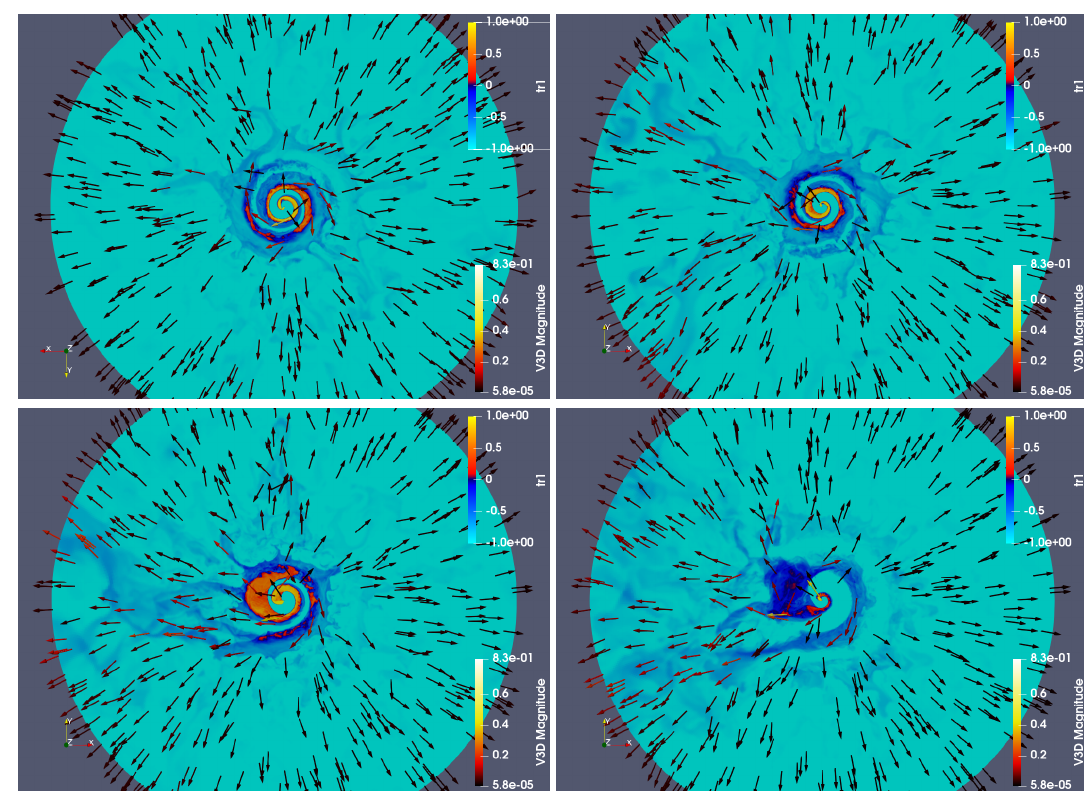
Figure 2. The same as in Figure 1 but for tracer, where 1 and − 1 correspond to the injected pulsar and stellar winds, respectively.